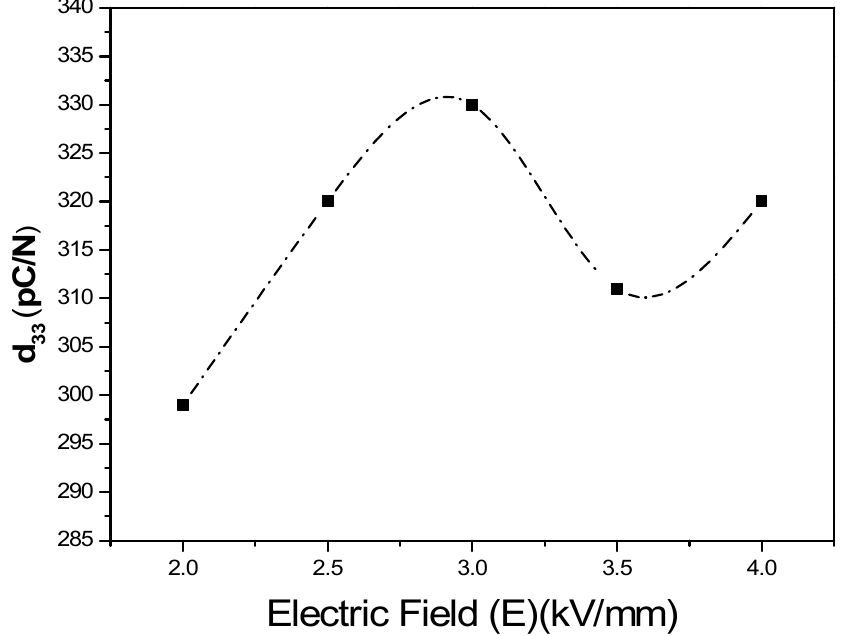
Figure 9. Piezoelectric constant (d 33 ) of x = 0.07 samples with electric field. As the electric field (E) increased, the piezoelectric constant d 33 increased. When the electric field (E) was 3 kV/mm, the maximum d 33 = 330 pC/N was obtained. Thereafter, the piezoelectric constant d 33 was decreased due to a micro-cracking phenomenon under over electric field (E) of the specimen.